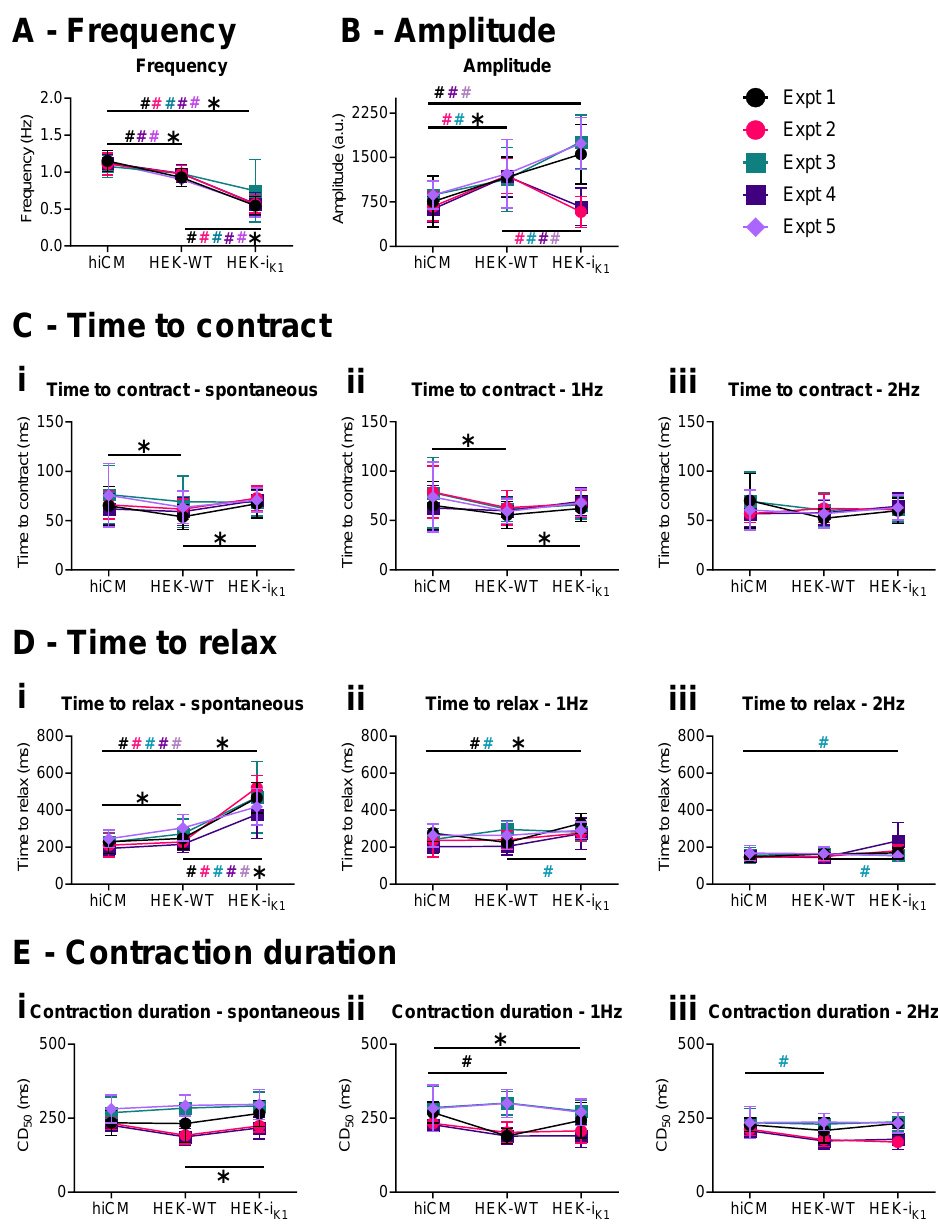
Figure 2. Cell movement effects of the 1:1 co-culture on day 4 in vitro in serum-free conditions, showing observations from individual experiments. Each plating is shown in a different color, and data are presented as mean+/−SD. ( A ) Frequency of spontaneous contraction. ( B ) Amplitude of the spontaneous contraction. ( C ) Time to contract at ( Ci ) spontaneous, ( Cii ) 1 Hz, and ( Ciii ) 2 Hz conditions. ( D ) Time to relax at ( Di ) spontaneous, ( Dii ) 1 Hz, and ( Diii ) 2 Hz. ( E ) This shows 50% of the contraction duration at ( Ei ) spontaneous, ( Eii ) 1 Hz, and ( Eiii ) 2 Hz. The comparison of each culture (hiCM, HEK–WT:hiCM and HEK-I K1 :hiCM) within each experiment is shown as # in the respective experimental, and 2-way ANOVA was used for statistical analysis. The mean of all experiments was then compared using a paired t -test and this is shown as * ( p <